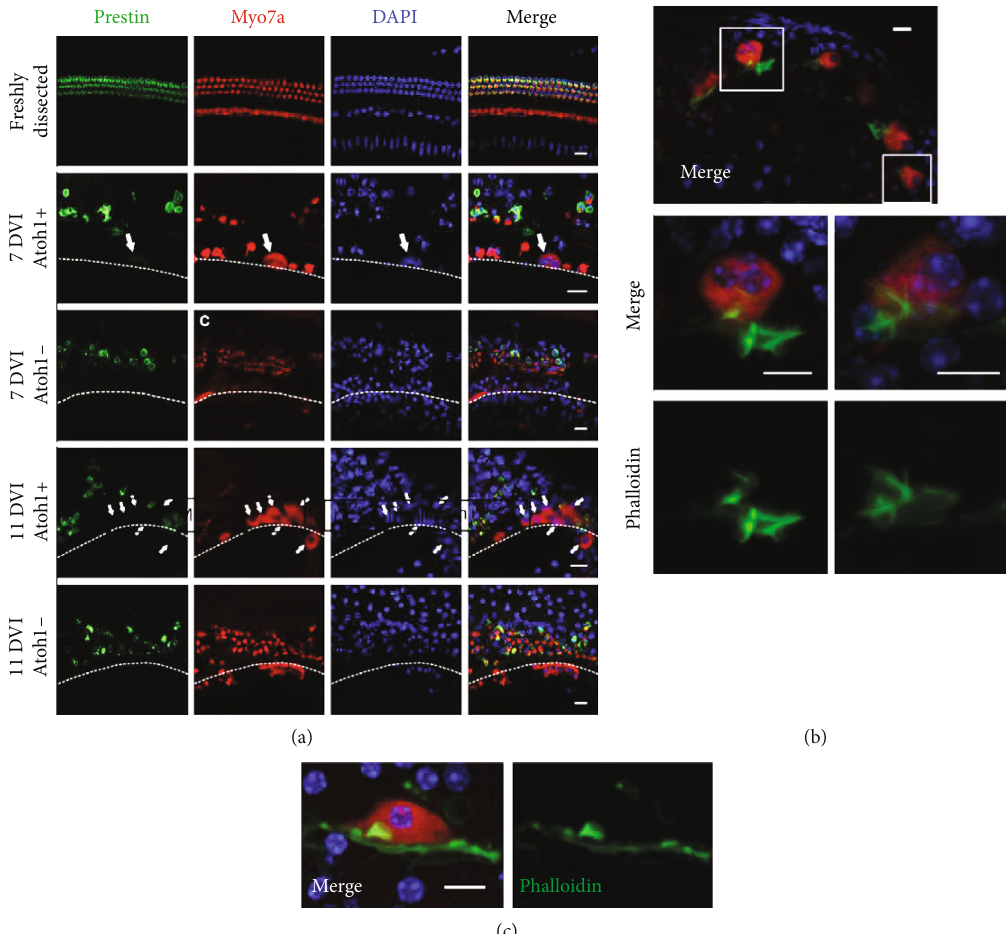
Figure 3: Atoh1 -induced HCLCs possessed bundles similar to developmental HCs but did not express prestin in mature cochleae. (a) Distribution of prestin in a freshly dissected cochlea of an adult mouse. HCLCs (arrows) and remnant IHCs were prestin negative, and remnant OHCs were prestin positive at 7 and 11 DVI after Atoh1 infection. (b) Hair cell bundles were observed at the apical side of HCLCs. (c) Several HCLC bundles were relatively well organized with V-shaped structures. Scale bar = 15 μ m in (a), 10 μ m in (b) and (c). Rectangular boxes show areas from which high magni fi cation and dashed lines mark the IHC